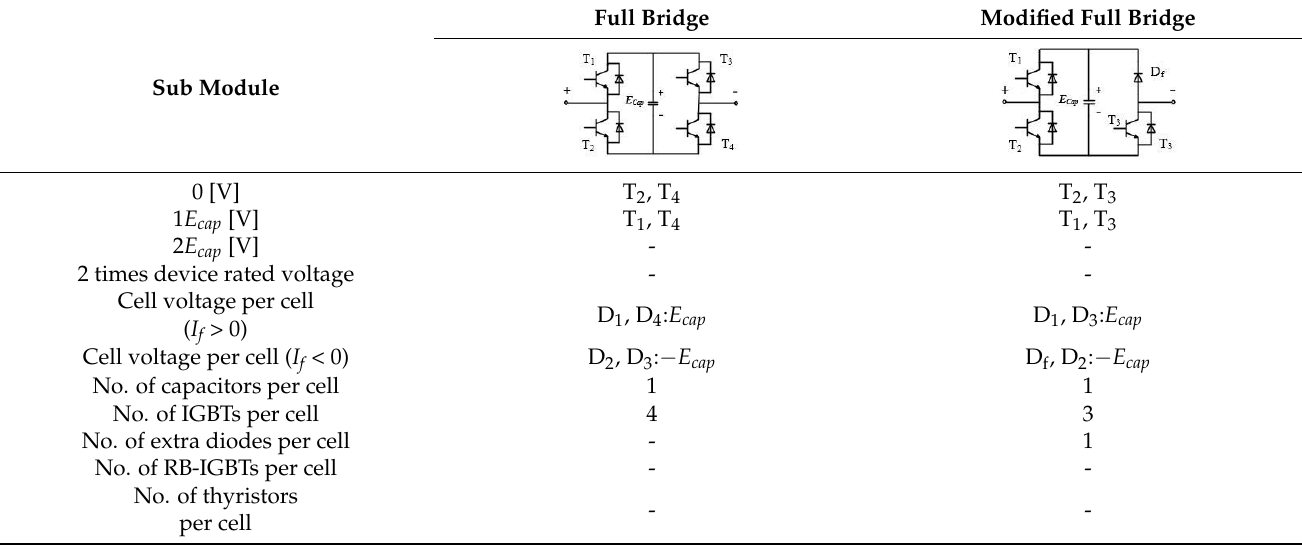
Table A1. Comparison between conventional sub-module topologies with FRT capability (two-level cell). Sub Module